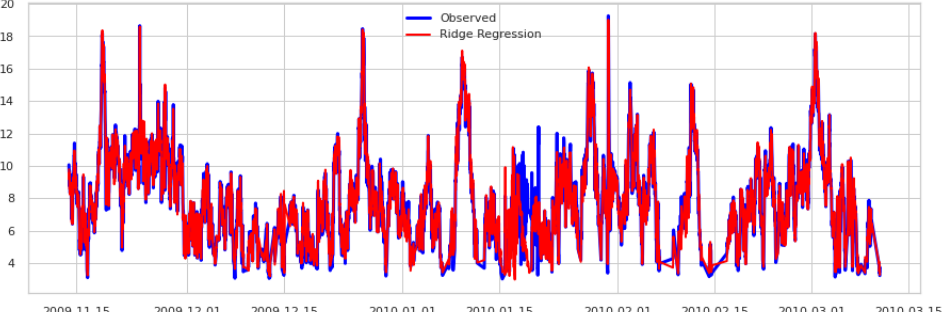
Figure 13. Wind speeds prediction from the Ridge regression using mesoscale and observed data. The units are in ms − 1